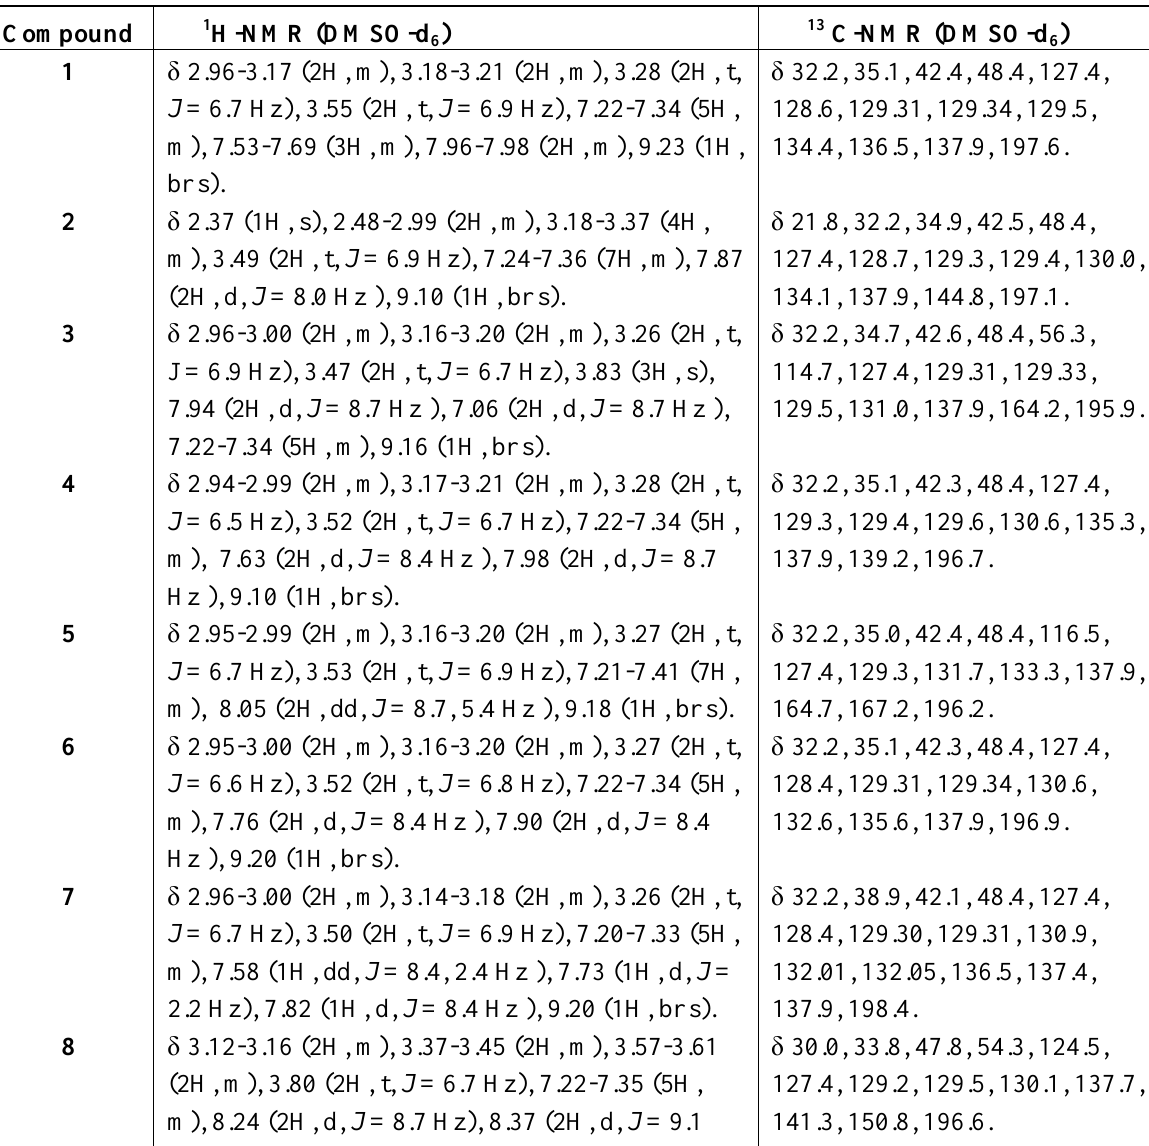
Table 1. 1 H- and 13 C-NMR spectra of the synthesized compounds 1-10 .